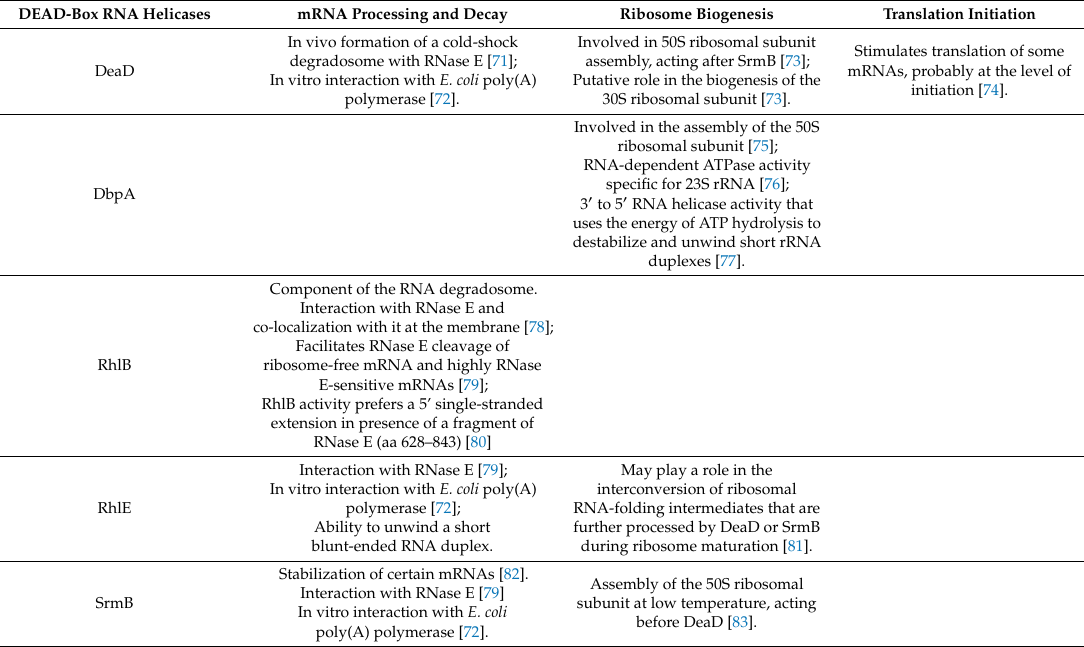
Table 1. Main functions associated with DEAD-box RNA helicases in E.